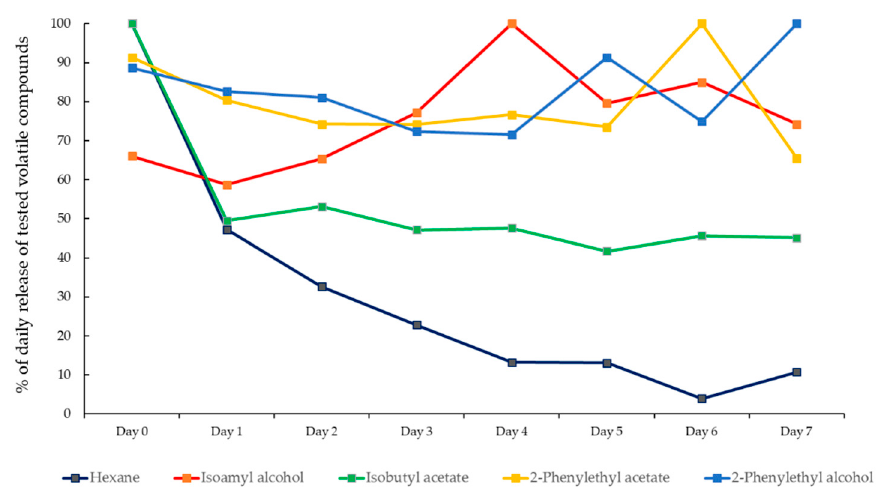
Figure 3. Daily release of four olive fruit fly-associated yeast volatile compounds (isoamyl alcohol, 2-phenethyl alcohol, 2-phenethyl acetate, isobutyl acetate) and hexane as control during seven days. Samples were measured daily, for seven days, and analyzed using HS-SPME– GC/FID yielded peak area results, reflecting the amount of each sample present in the vial.